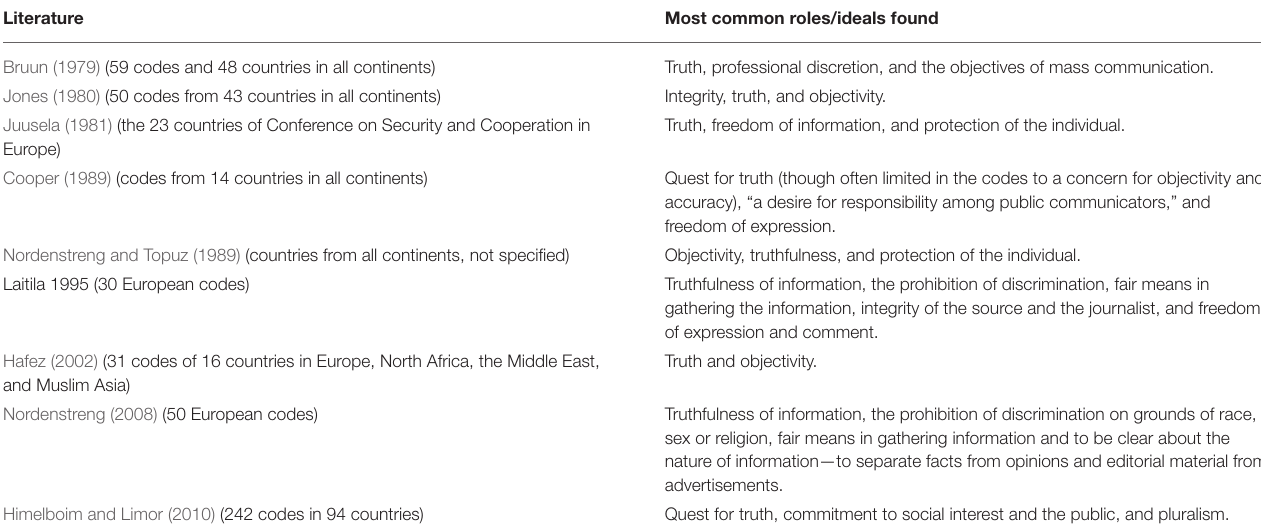
TABLE 1 | Comparative works on the roles included in deontological codes. Literature Most common roles/ideals found Bruun (1979) (59 codes and 48 countries in all continents) Truth, professional discretion, and the objectives of mass communication. Jones (1980) (50 codes from 43 countries in all